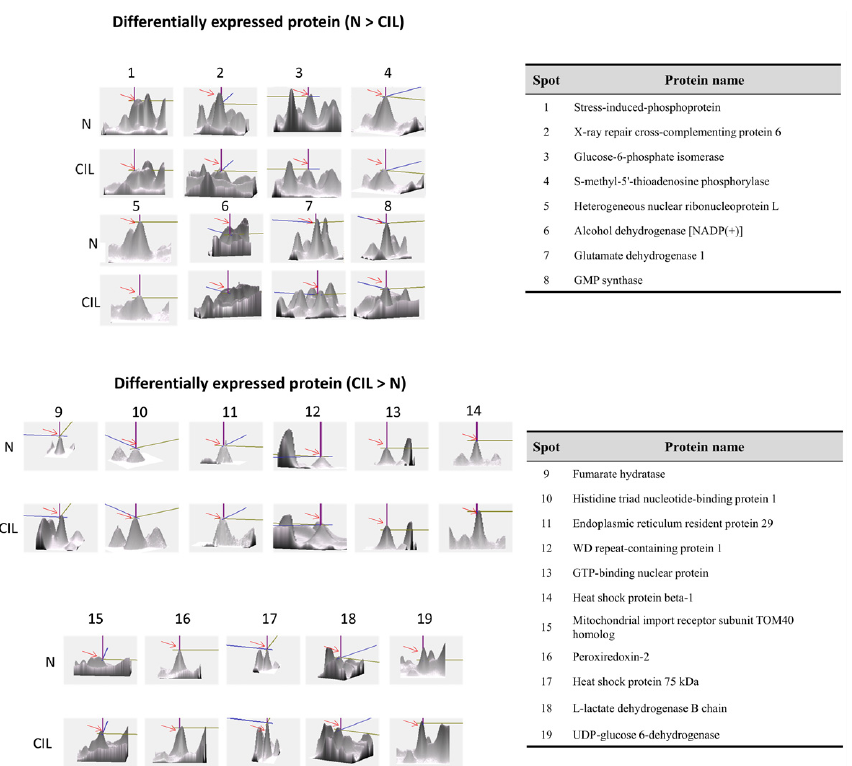
Figure 5. A representative close view of CIL-102-mediated differentially expressed proteins. The expression pattern of differentially expressed proteins (the number is the same as in Table 1) in DLD-1 cells, with or without CIL-102 treatment (one pair of experiments), are shown. Six pairs of cell protein extracts with four reproducible blots were performed in total.